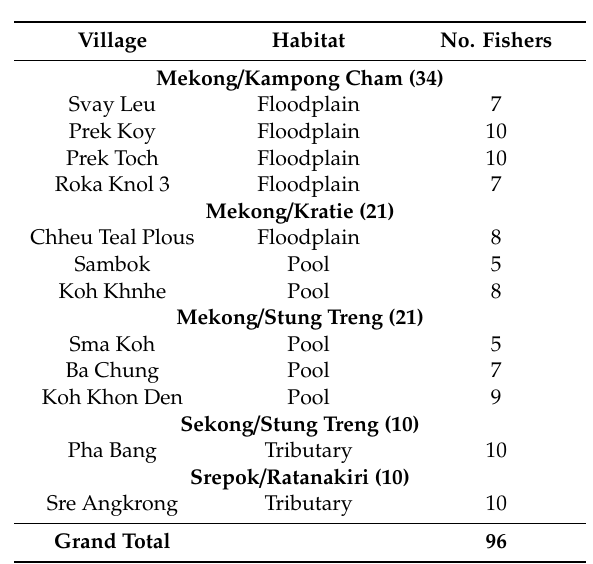
Table 2. The number of fishers interviewed in each village. Villages are grouped by river section. Bold numbers in parentheses are the number of fishers interviewed in each river section and are subtotals of the number of fishers interviewed from the villages within the river section. Villages are ordered from downstream to upstream. Habitat indicates the habitat type where the village was located (see text for more